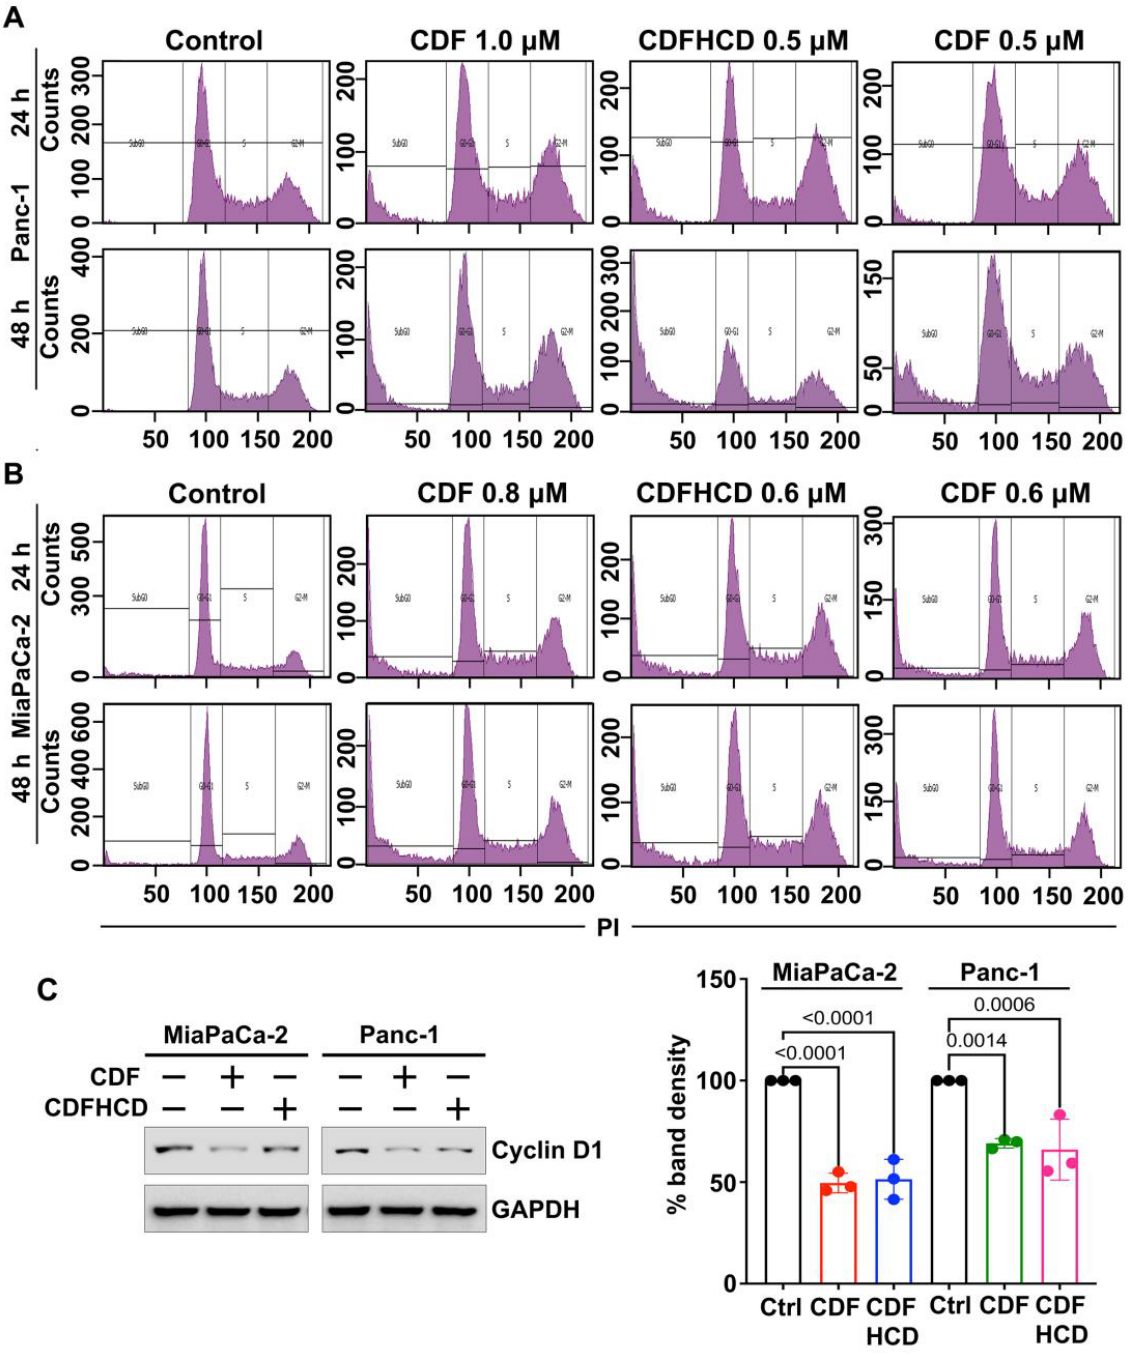
Figure 5. Cell cycle analysis of CDF and CDFHCD in PDAC cells. ( A ) MiaPaCa-2 and ( B ) Panc-1 cells were incubated with CDF and CDFHCD for 24 h and 48 h and analyzed by flow cytometry using FxCycle TM PI/RNase staining solution. ( C ) Cell lysates from CDF and CDFHCD-treated MiaPaCa-2 and Panc-1 were analyzed using western blot to study the changes in cyclin D1 expression.